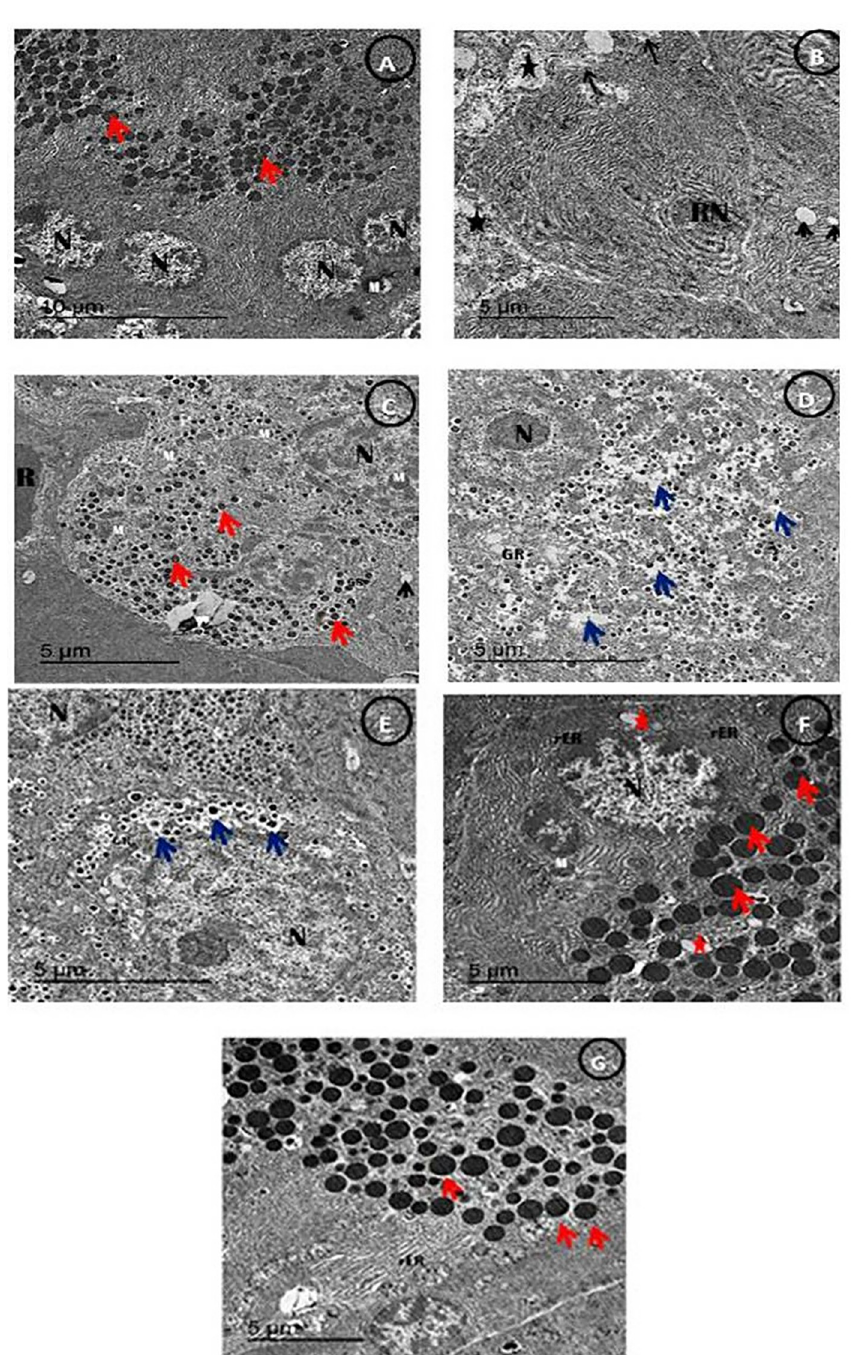
Fig 14. An electron micrograph of β -cells of the pancreatic tissues showing (A) control group showing β -cells with normal distinct intracellular spaces showing normal multi euchromatic rounded nuclei (N), normal sized mitochondria (M) with appearing of normal sized β -granules with an electron dense core (Red arrow) (Scale bar = 10 μ m). (B) STZ treated group showing detached pancreatic parenchyma (Black star) with reduced nucleus (RN) with disappearance of β -granules and appearance of some empty granules (Black arrow) with reduced sized mitochondria (Black arrow) (Scale bar = 5 μ m). (C) STZ plus stem cell group showing restoration of pancreatic parenchyma with appearance of some small sized β -granules (Red arrow) with appearance of β -granular area (GR) with remaining of some Red blood corpuscles (R) and enlarged size mitochondria (M) than STZ group with appearance of nucleus (N) and appearance of some vacuoles (V) (Scale bar = 5 μ m).(D) STZ plus (Q) group